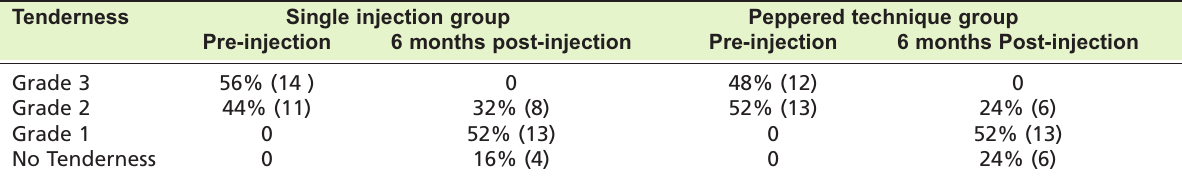
Comparison between pre-injection and post-injection tenderness among the two groups Table II: Tenderness